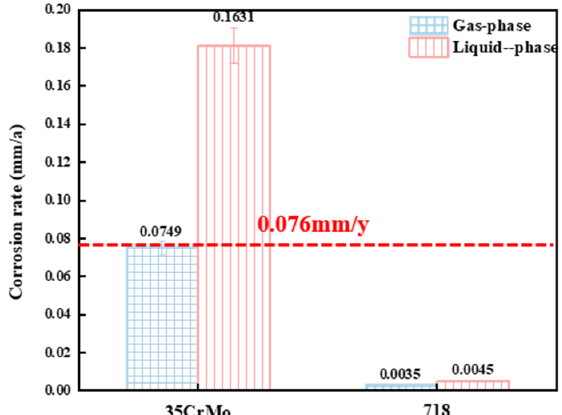
Figure 7. The corrosion rate of carbon steel and 718 alloys used for the packer in the gas and liquid phase.